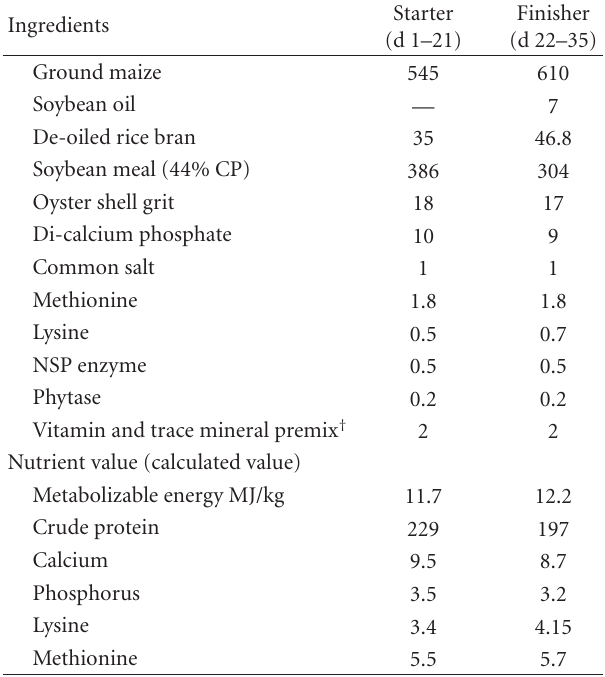
Table 1: Composition of basal diet (g/kg unless stated otherwise).